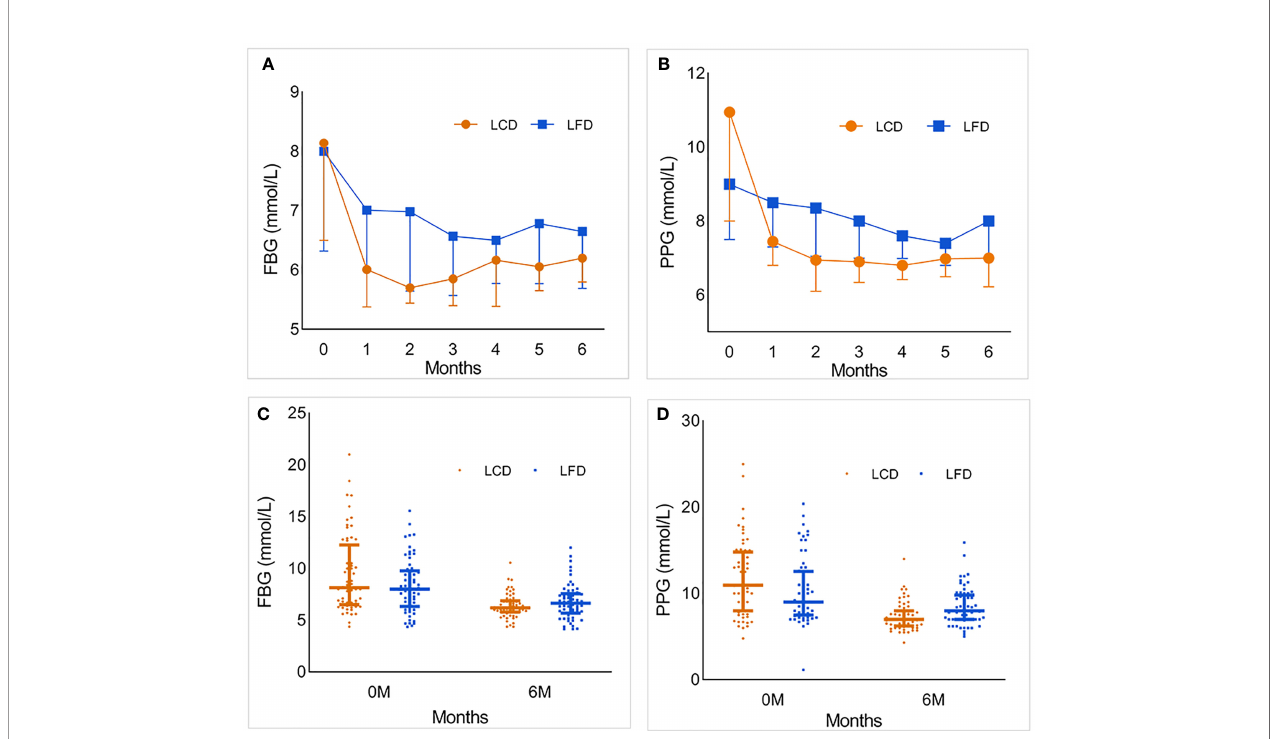
FIGURE 4 | The foldline and scatter diagram which describe the changing trends and distribution of the FBG and PPG of the two groups during the intervention. (A) The foldline diagram of FBG in the LCD and LFD group. FBG in both groups decreased signi fi cantly in the fi rst month, then gradually become stabilized. And the range in LCD group was more obvious. In the second half of follow-up, FBG fl uctuated slightly. (B) The foldline diagram of PPG in the LCD and LFD group. The changing trend was similar with FBG. (C, D) The scatter diagram of FBG and PPG in the two groups. There was no signi fi cant difference in the distribution of FBG and PPG between the two groups at baseline. After 6 months, the level of FBG and PPG in LCD group were lower than LFD group. LCD, Low-carbohydrate diet; LFD, Low-fat diet; FBG, fasting blood glucose; PPG, postprandial 2-h blood